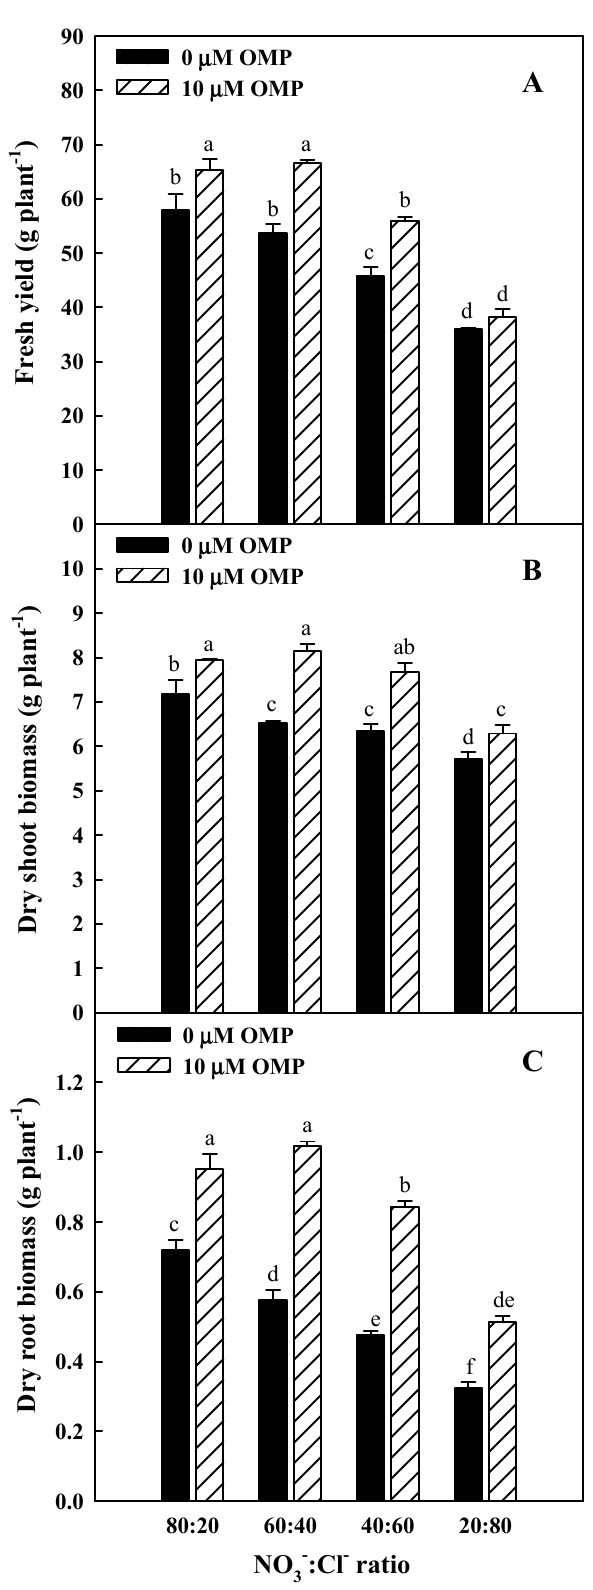
Figure 1. Effects NO 3 − :Cl − ratio in the nutrient solution and omeprazole (OMP) application rates on marketable ( A ) fresh yield, ( B ) dry shoot biomass and ( C ) dry root biomass of greenhouse hydroponic basil plants. Different letters indicate significant differences according to Duncan’s test ( p = 0.05). Values are the means of three replicate samples. Vertical bars indicate ± standard error of means.